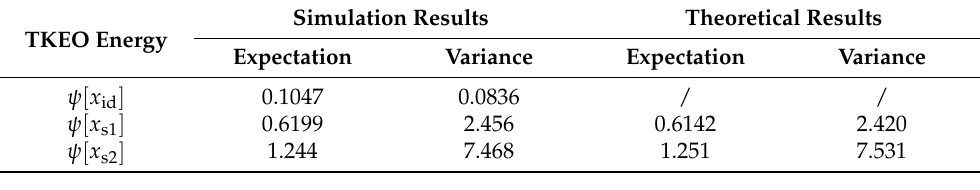
Table 2. The theoretical and simulation results of the expectation and variance of TKEO energy.